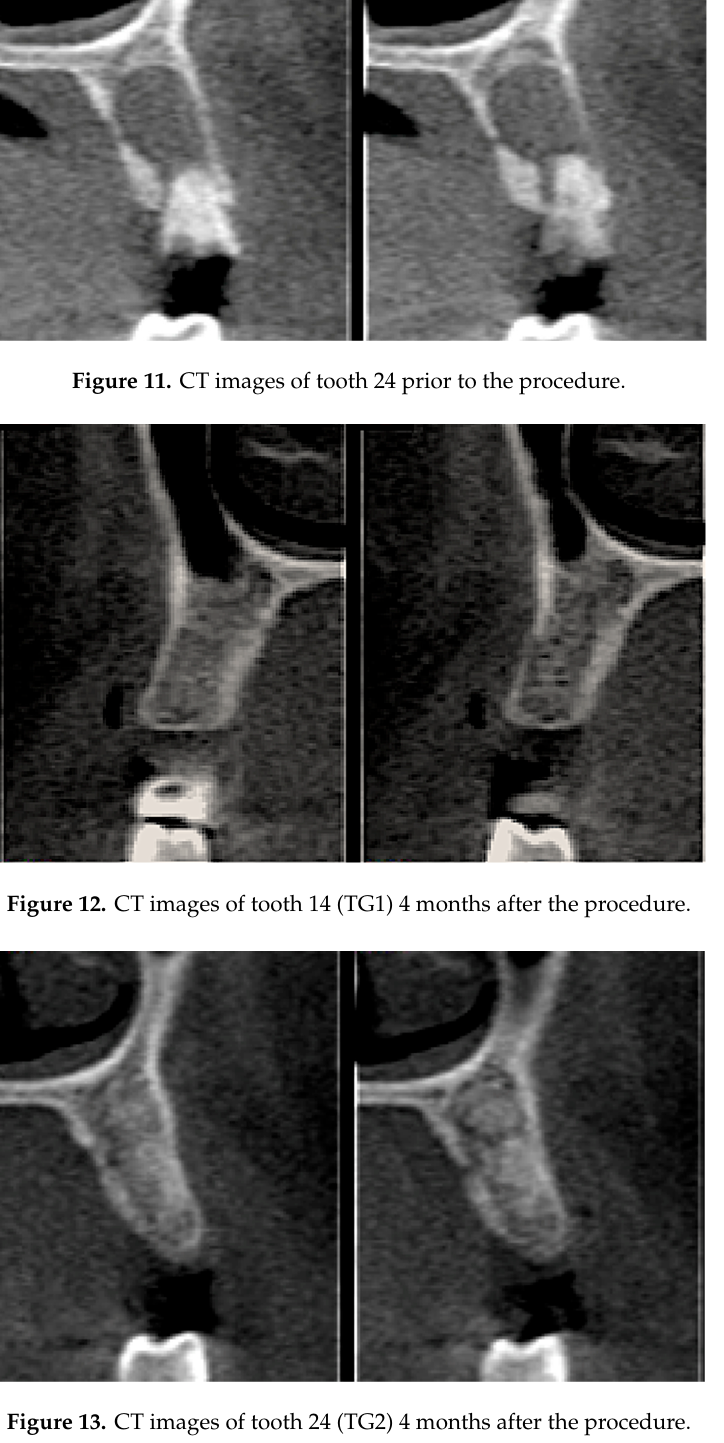
Figure 13. CT images of tooth 24 (TG2) 4 months after the procedure.